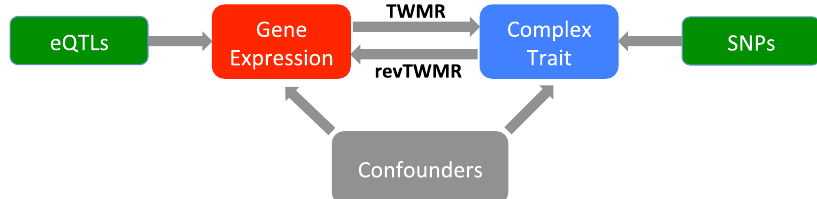
Fig. 1 TWMR and revTWMR. Schematic representation of how TWMR and revTWMR dissect bidirectional causal and confounder contributions to the observed correlation between gene expression and